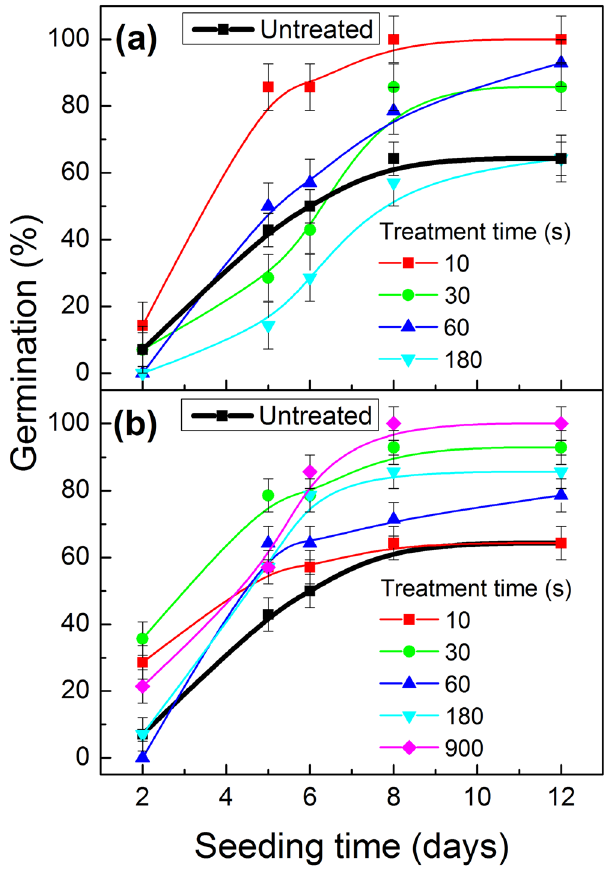
Figure 1. Plots of germination percentages as a function of seeding time for quinoa seeds plasma treated for the indicated periods of time in the RF (top) and DBD (bottom)